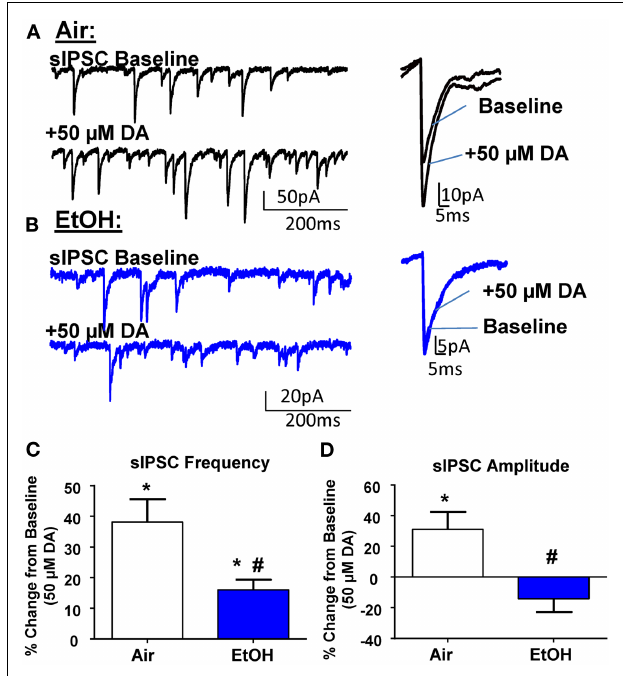
FIGURE 2 | Ethanol exposure impairs D1R-mediated facilitation of GABA A receptor-mediated spontaneous inhibitory postsynaptic currents (sIPSCs) in the BLA . Exemplar compressed traces of sIPSC recordings obtained under baseline conditions and in the presence of 50 µ M dopamine (DA) in slices from (A) Air- and (B) EtOH-exposed animals. Exemplar expanded scale traces of averaged sIPSCs are shown adjacent to compressed traces. (C) 50 µ M DA significantly increased sIPSC frequency in Air animals (* p < 0.01 by one sample t -test compared to 0) and EtOH animals (* p < 0.01 by one sample t -test compared to 0).The DA-induced increase in sIPSC frequency was significantly attenuated in EtOH compared to Air-exposed animals ( # p < 0.05 by unpaired t -test). (D) sIPSC amplitude was significantly increased by 50 µ M DA in Air (* p < 0.05 by one sample t -test compared to 0), but not EtOH-exposed animals ( p > 0.05 by one sample t -test compared to 0).The DA-induced potentiation of sIPSC amplitude was significantly blunted in the EtOH compared to Air-exposed animals ( # p < 0.05 by Mann–Whitney test). N = 8 animals from 8 Air and 7 EtOH